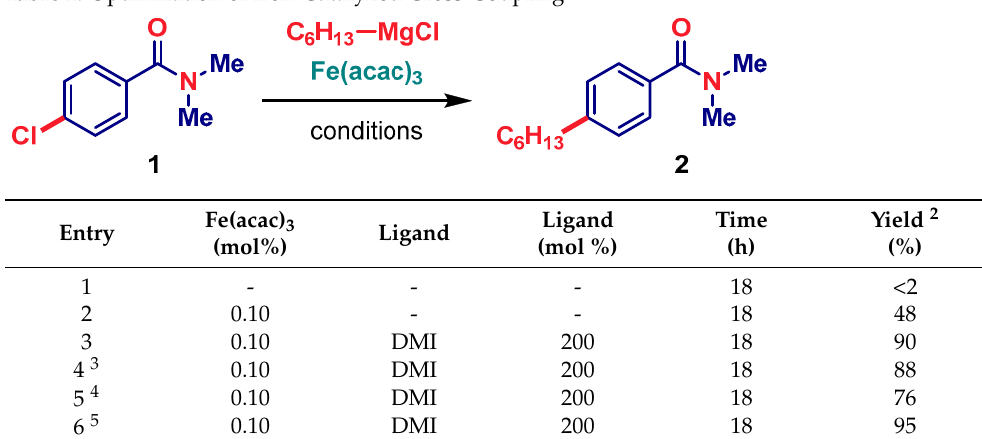
Table 1. Optimization of Iron-Catalyzed Cross-Coupling 1 .